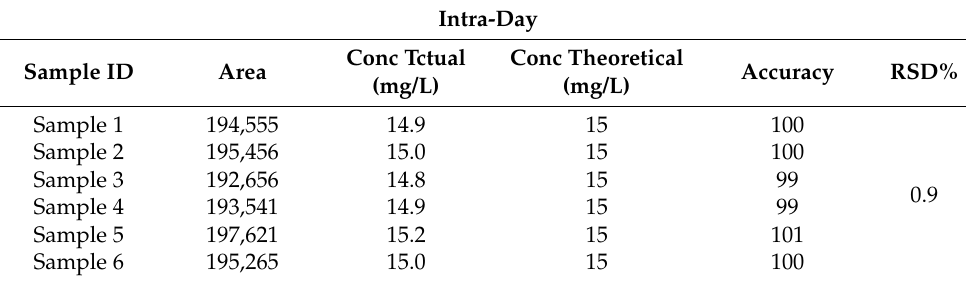
Table 5. Intermediate precision (Intra-day) of